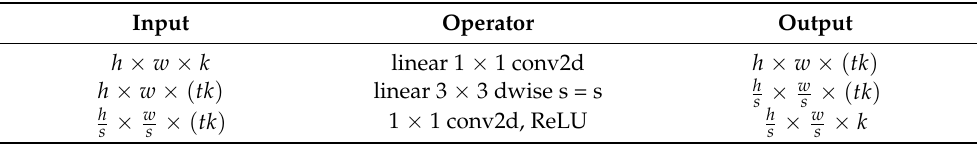
Table 1. Single linear bottleneck block transforming from k to k (cid:48) channels, with stride s, and reduction factor